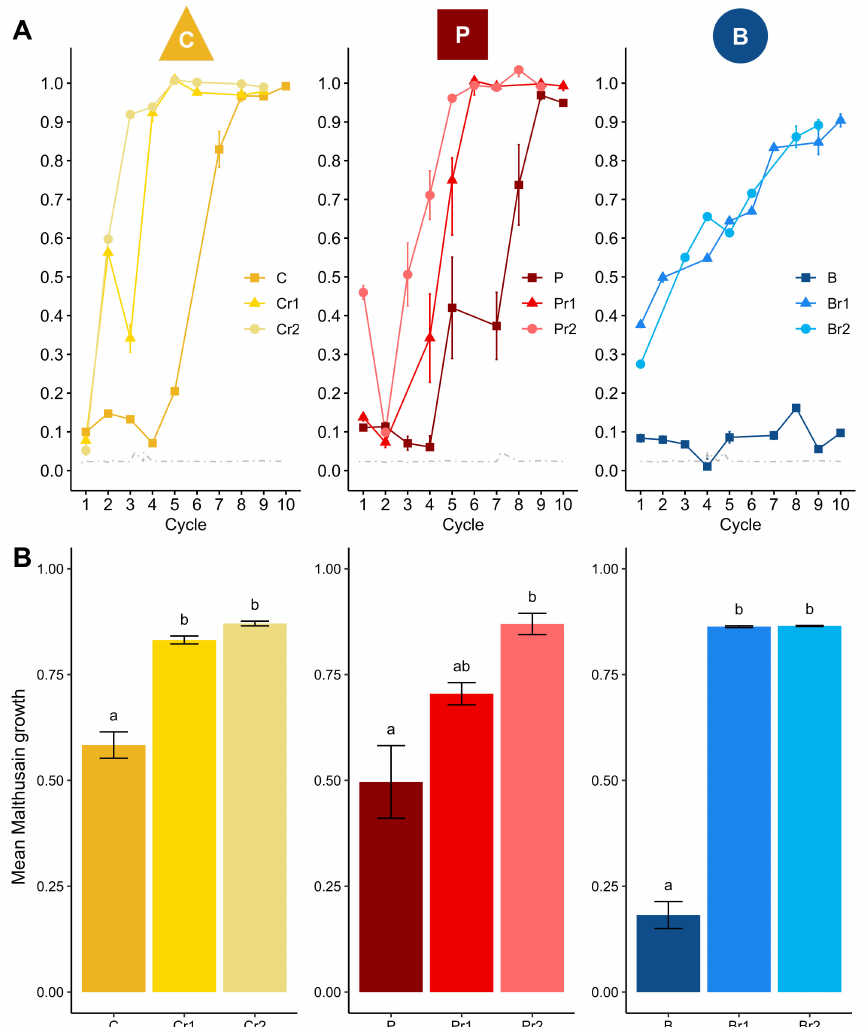
Figure 3. Dynamics of resistance evolution in the lines exposed to a single fungicide at the full efficient dose or a reduced dose. Each column represents results for an AI used at its EC 90 selection dose or at two reduced doses, corresponding to a fraction of this EC 90 (Table 1). B: benzovindiflupyr (SDHI), C: carbendazim (benzimidazole) and P: prothioconazole-desthio (DMI). ( A ) The normalised spore concentration is the spore concentration observed at the end of a cycle divided by the spore concentration in the control line (i.e., a susceptible population not exposed to fungicides). ( B ) Mean Malthusian growth. Results are normalised against the Malthusian growth of the control (histogram bars) and are presented with their standard deviations (upper and lower lines). Different letters indicate significant differences between groups ( P <